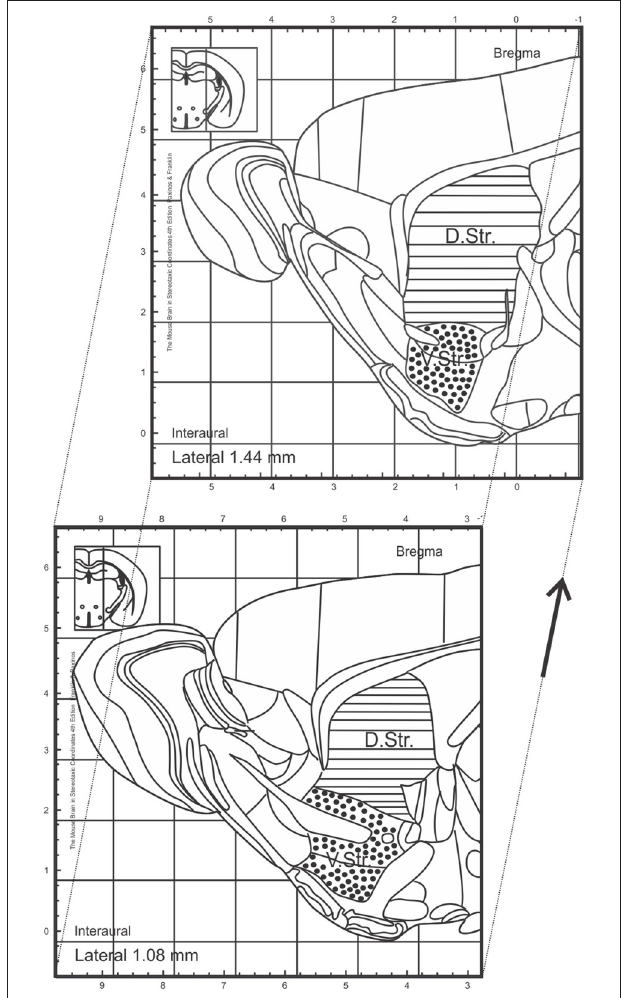
FIGURE 1 | Topographical map of sagittal sections of adult mice adopted from Franklin and Paxinos (2013). Regions analyzed within this study are marked and include the dorsal and ventral striatum. Sections analyzed between interaural lateral 1.44 and 1.08mm. D.Str., dorsal striatum; V.Str., ventral